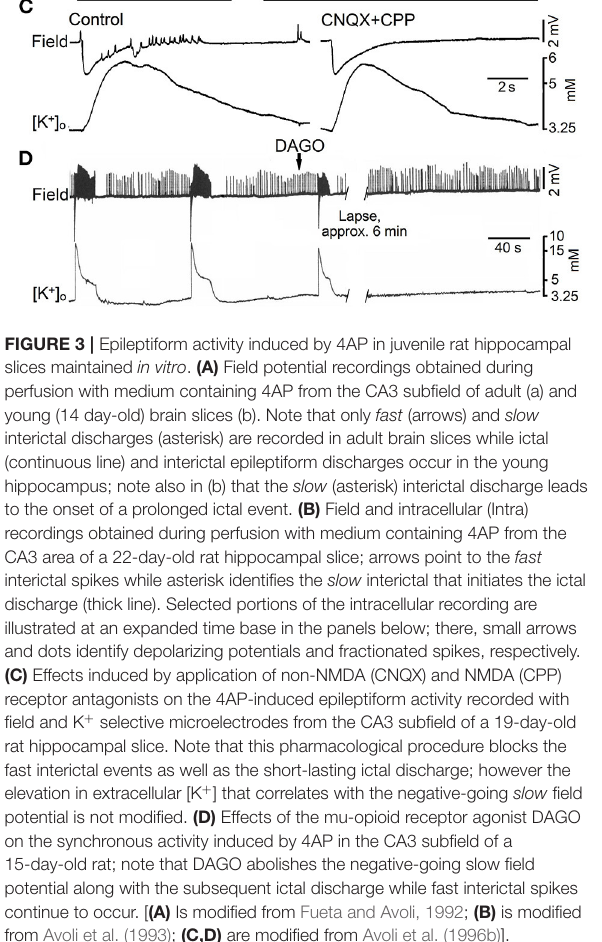
Ari et al., 1979) or neocortex (Kostopoulos et al.,